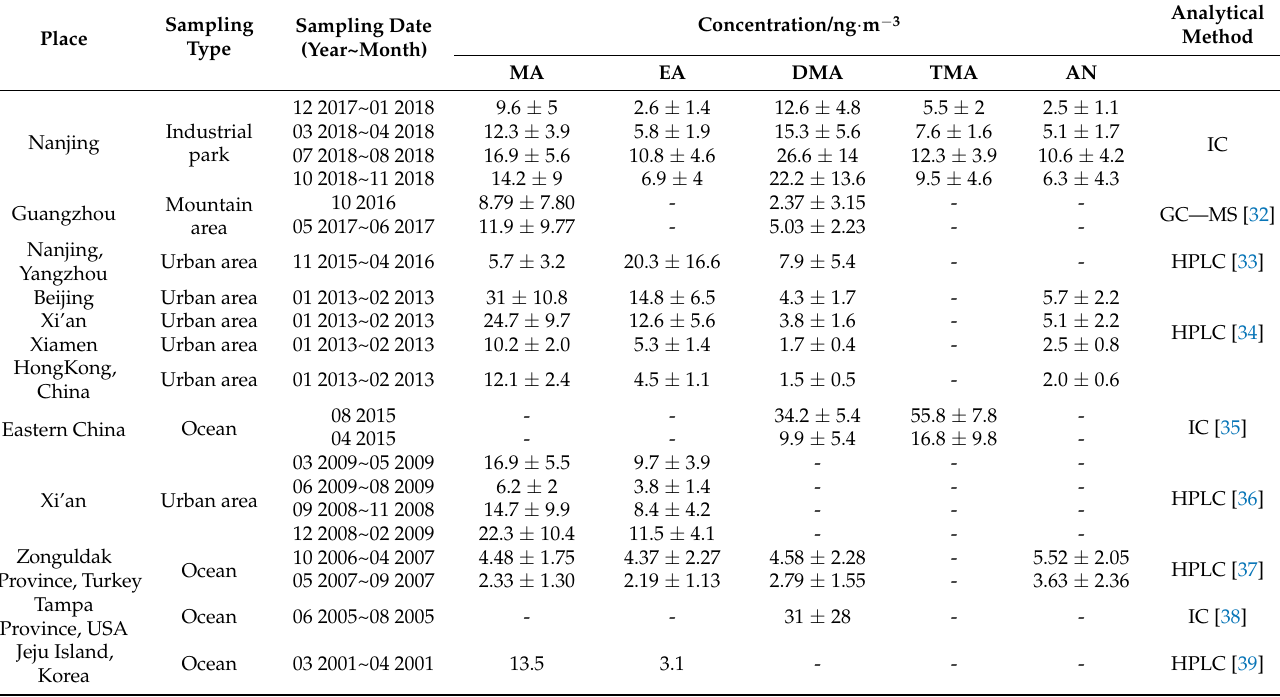
Table 1. Comparison of OA concentration in atmospheric particulate